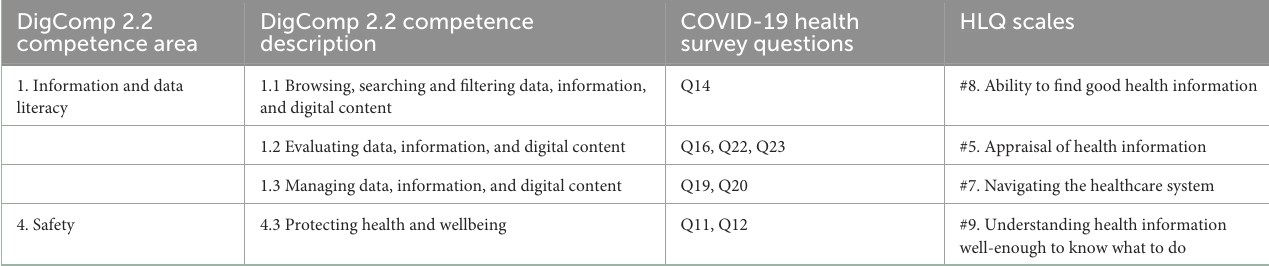
TABLE 1 DigComp 2.2, HLQ, and COVID-HL-Survey